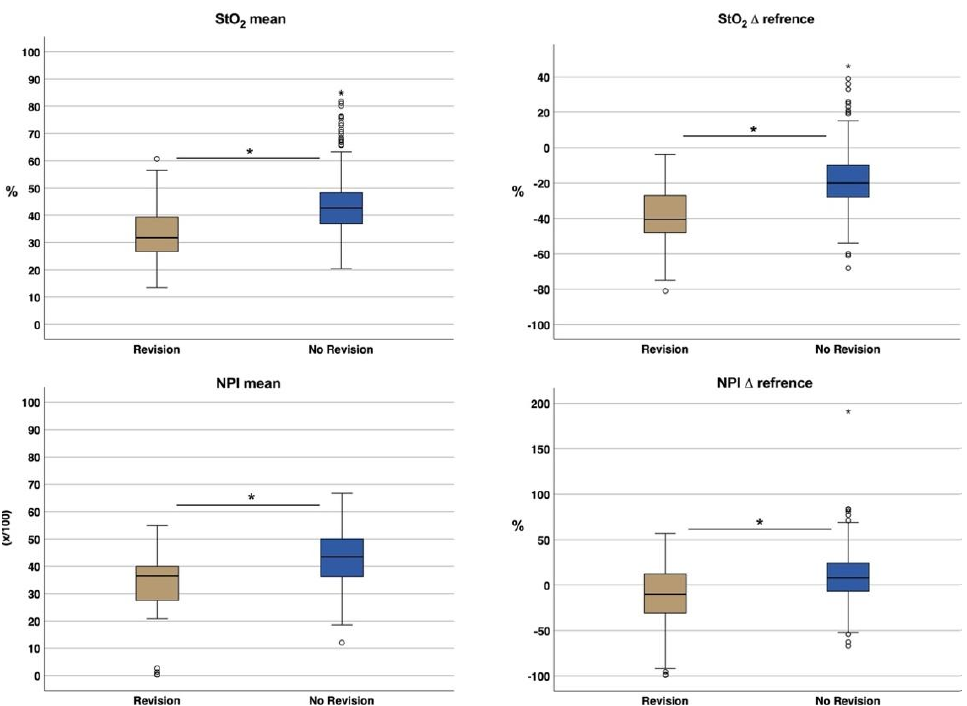
Figure 8. Boxplot showing the distribution of StO2, StO 2 Δ reference, NPI and NPI Δ reference comparing flaps with and without revision following poor perfusion. Asterisk (*) marks existing significance.